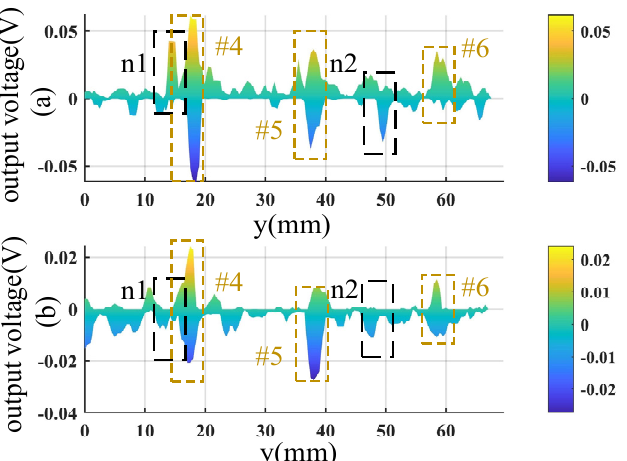
Figure 13. Zoom-in plots of defects #4 − #6: ( a ) image of SD mode and ( b ) image of OD mode.